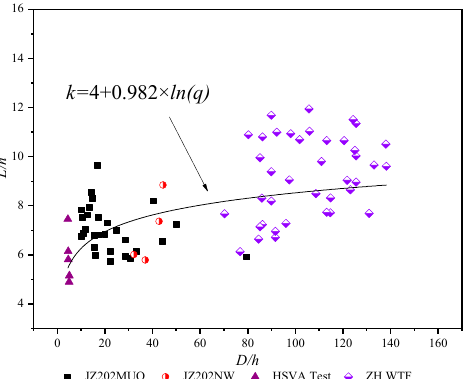
Figure 11. Length–thickness ratio, k , versus the width–thickness ratio, q . From the analysis of the measured data, it was found that the length–thickness ratio coefficient, k , was greater than 4, and the length–thickness ratio coefficient, k, on the cone, which is recommended in ISO19906 [23], ranged from 4~10. Therefore, we used a = 4 in the formula and obtained the relationship between the length–thickness ratio coefficient, k, and the width–thickness ratio coefficient, q, from the measured data; thus, the relationship between the average period of sea ice breaking and ice thickness and ice speed can be obtained: